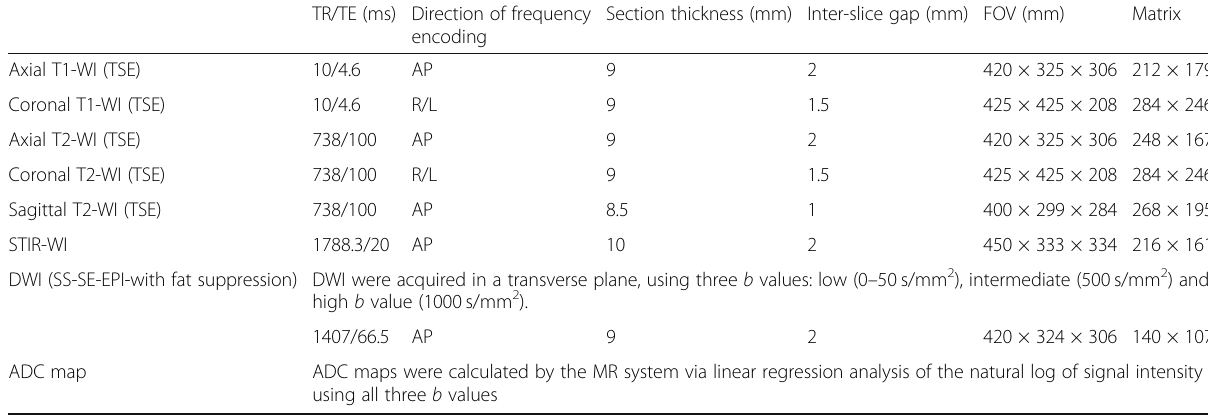
Abbreviations : TR : repetition time, TE : echo time, FOV : Field-of-view, WI : Weighted image, TSE : Turbo spin echo, STIR : Short tau inversion recovery, R/L : Right to left, A/P : Antero-posterior, SS-SE-EPI : Single-shot spin-echo echo-planar